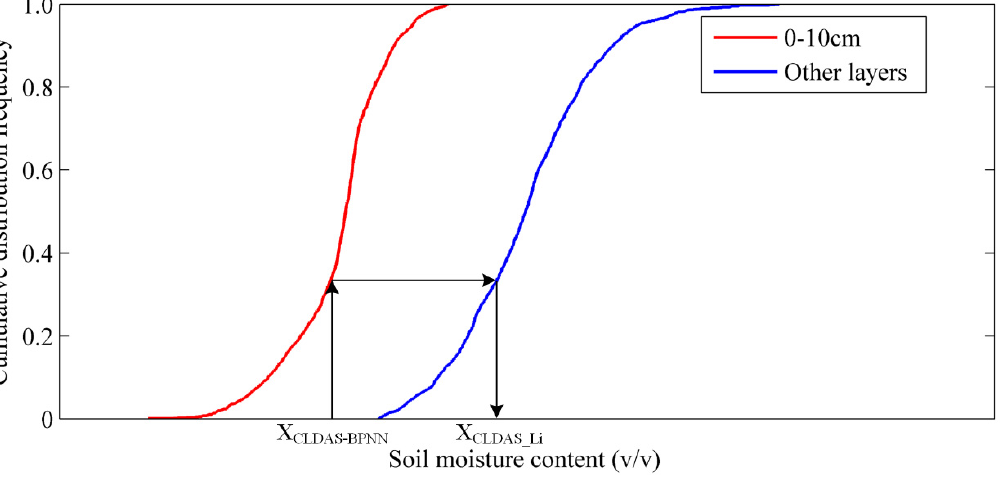
Figure 2. A graph showing how the CDF of CLDAS-BPNN SSM was adjusted into that of SM at other layers. 284 So, based on the CLDAS-BPNN SSM data, the SM data from the five CLDAS layers 285 were reanalyzed and processed with the CDF method (Equation (1)) to generate the cor- 286 responding BPNN-05, BPNN-40, BPNN-100 and BPNN-200 data for subsequent DA ex- 287 periments. For the convenience of writing, the CLDAS-BPNN SSM data are recorded as 288 BPNN-10 in a uniform format. 289